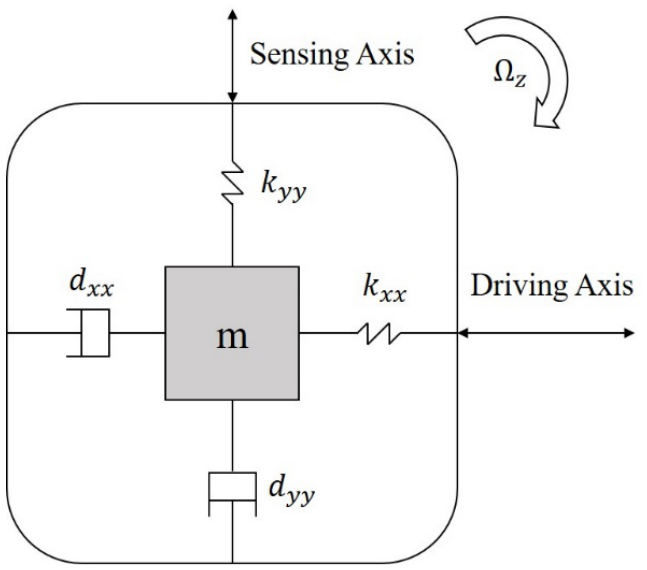
Figure 1. Structure of the micro gyroscope.